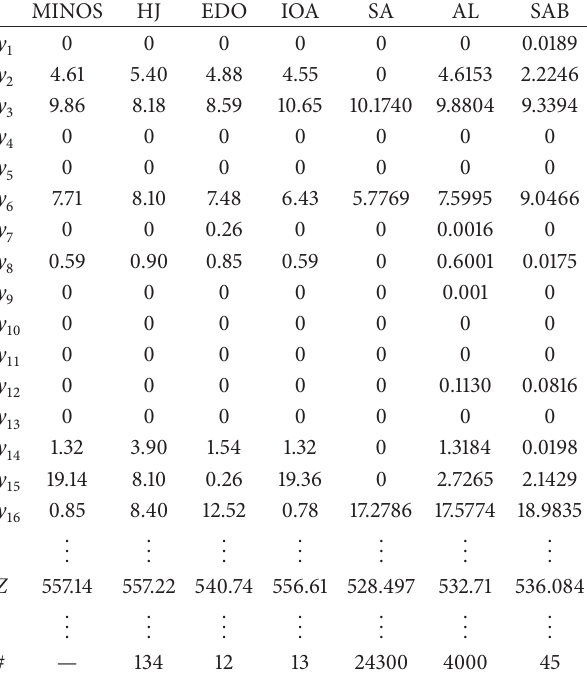
Table 6: Comparison of results from solving the 16-link network for scenario 2 (continued).